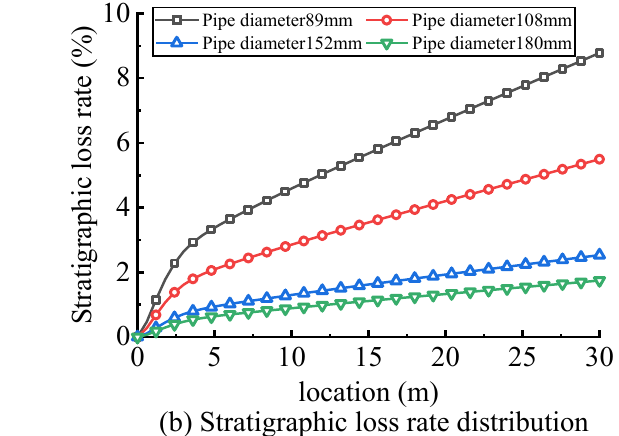
(b) Stratigraphic loss rate distribution